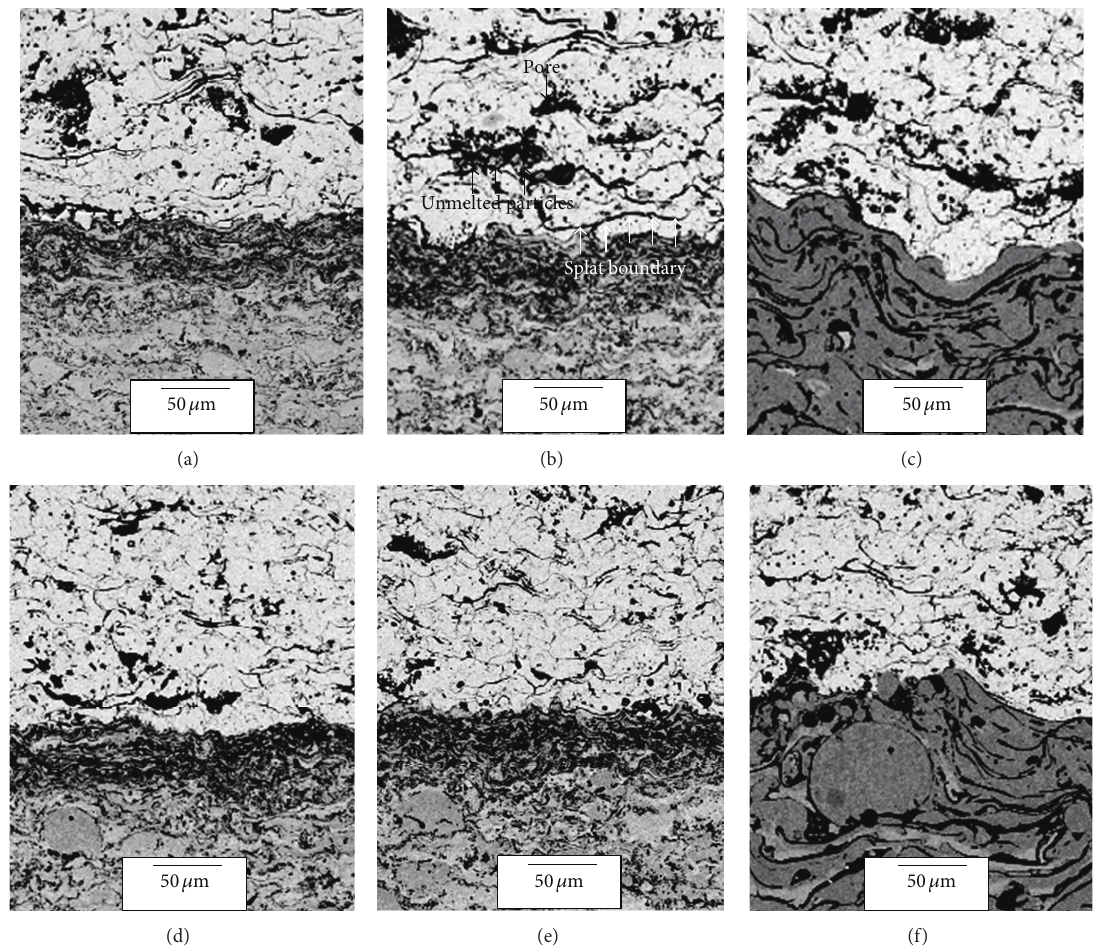
Figure 2: Highly magnified microstructures at the interfaces of the top and bond coats in TBCs: (a) TBC-A, (b) TBC-B, (c) TBC-C, (d) TBC-D, (e) TBC-E, and (f) TBC-F.